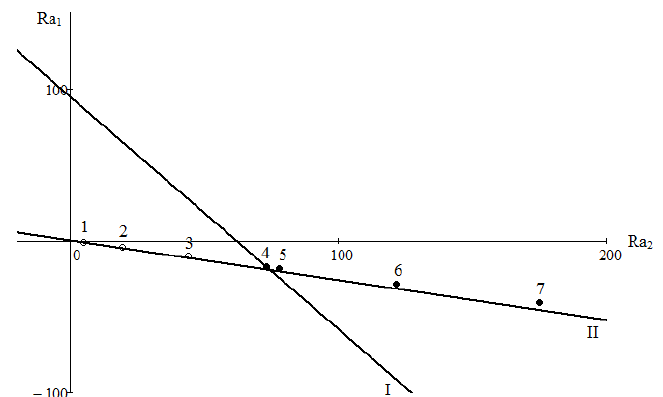
Figure 3. Map of stability for the system 0.4163H 2 + 0.5837CO 2 − N 2 : I is the neutral line of monotonic perturbations; II is the line of zero density gradient; 1–7 are the numerical data at different values of p: 1—0.2; 2—0.4; 3—0.6; 4—0.7; 5—0.8; 6—1.0; 7—1.2 MPa.